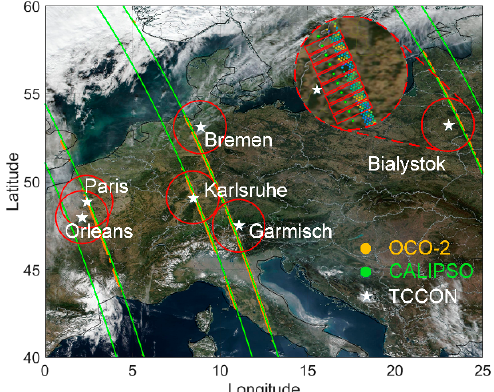
Figure 1. Distribution of selected TCCON (white pentagrams) sites in Europe. The orange lines show OCO-2 footprints passing over nearby TCCON sites, and the green lines show the CALIOP footprints. The dotted red circle shows the data fusion range between OCO-2 and CALIOP footprints.